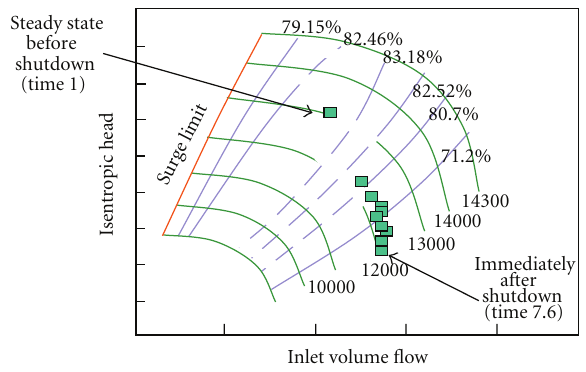
Figure 5: Typical operating points if transient conditions are considered, in this case due to the shutdown of one unit in a two- unit